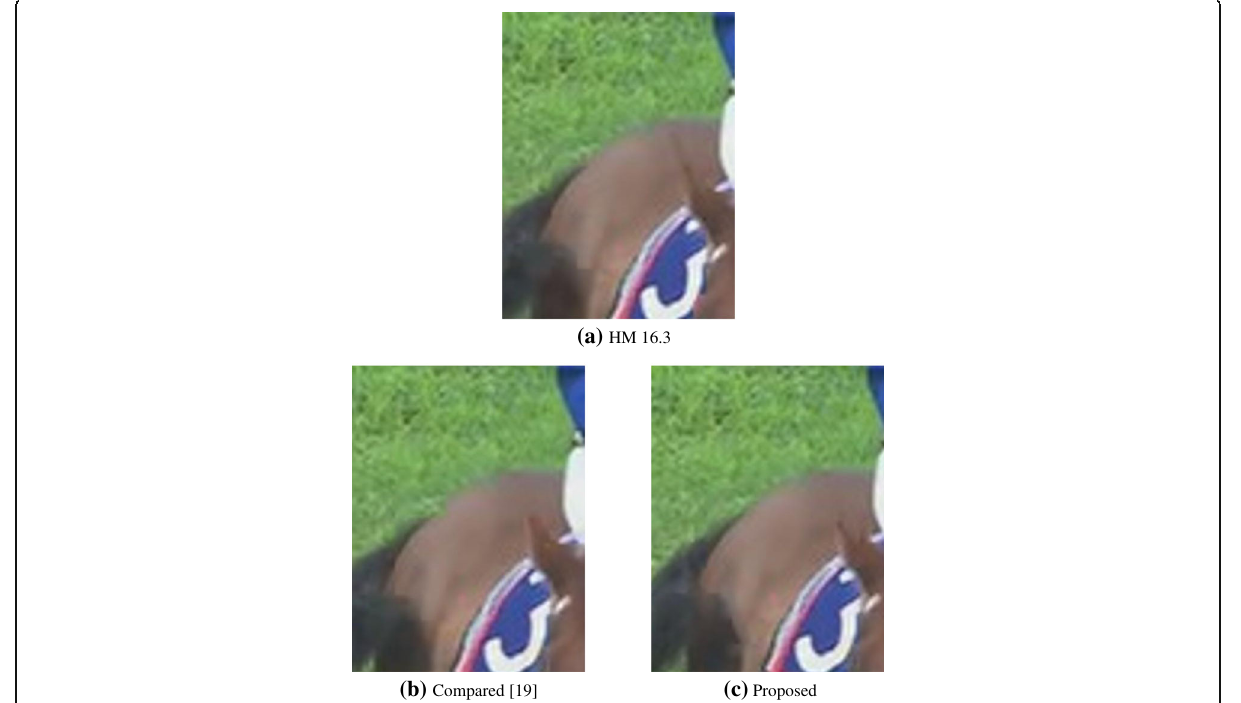
Fig. 21 Partial enlargements of the subjective comparison in the red circled region of Fig. 20. ( a ) HM 16.3. ( b ) Compared [19]. ( c ) Proposed